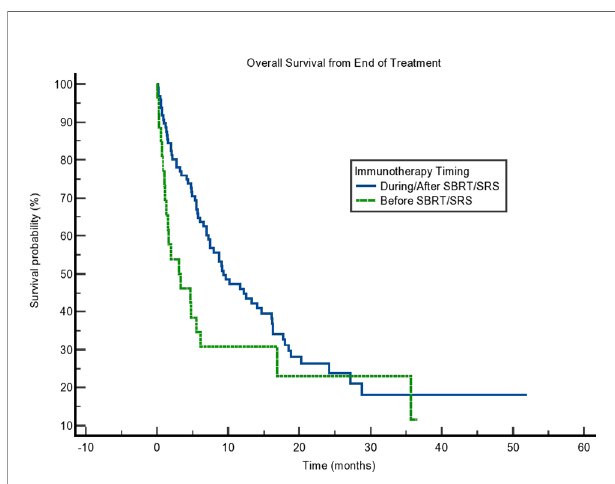
FIGURE 3 | Kaplan – Meier curve showing overall survival (OS) from the decision to start immunotherapy. OS based on immunotherapy given during/ after stereotactic body radiotherapy (SBRT)/stereotactic radiosurgery (SRS) compared to before SBRT/SRS. p = 0.81.